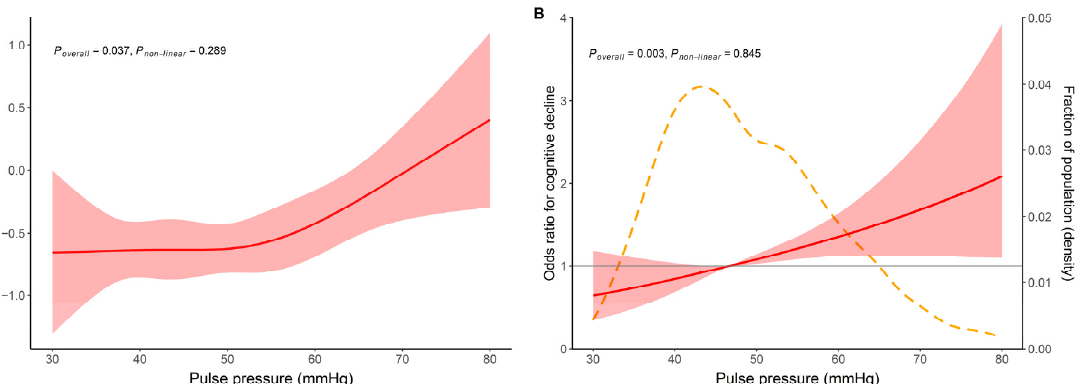
Figure 2. Restricted cubic spline for the relation between PP and ∆ MMSE or cognitive decline. ( A ) PP and ∆ MMSE; ( B ) PP and cognitive decline. Solid red line showed predicted value of ∆ MMSE in Figure 2(B) and odds ratio in Figure 2(B) Shaded areas indicate 95% confidence intervals, and the fraction of the population with different levels of PP is indicated by the dashed yellow curve.